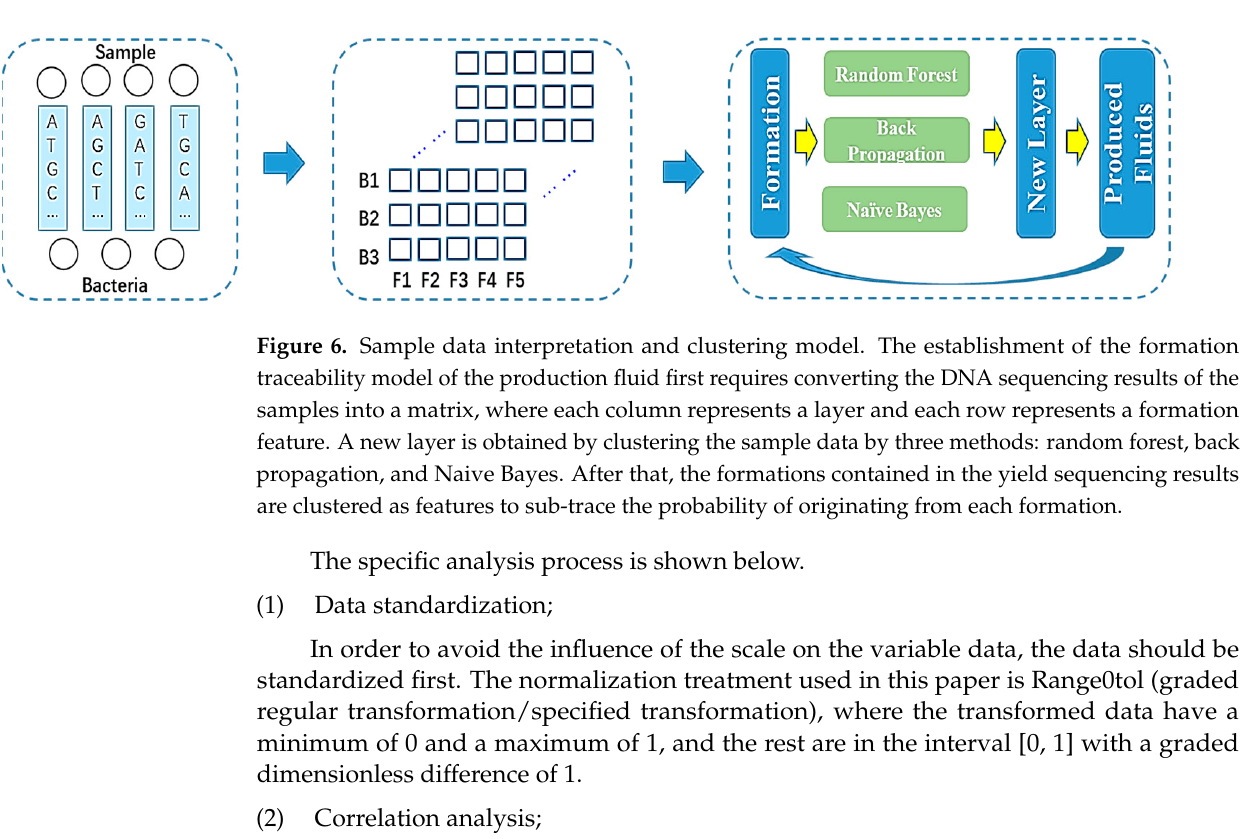
Figure 5 . Data on the input side of the produced fluids traceability model. The data includes bacteria species and their percentage in each formation.